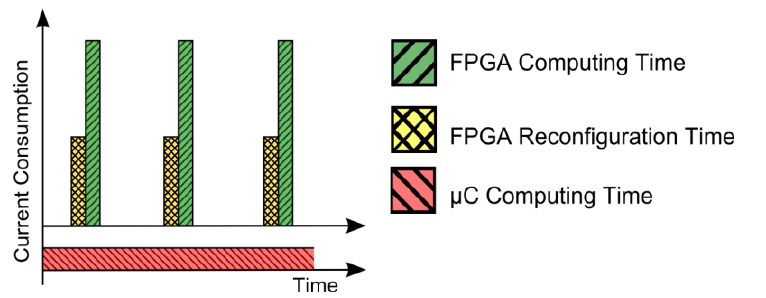
Figure 1. Consumption profile